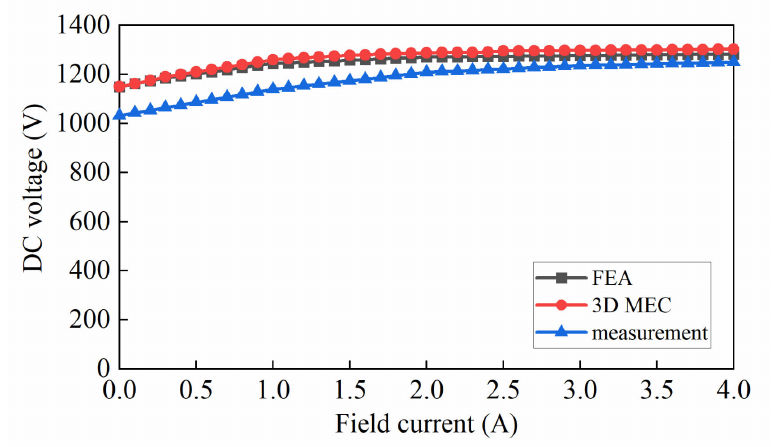
Figure 13. DC-Bus voltage.